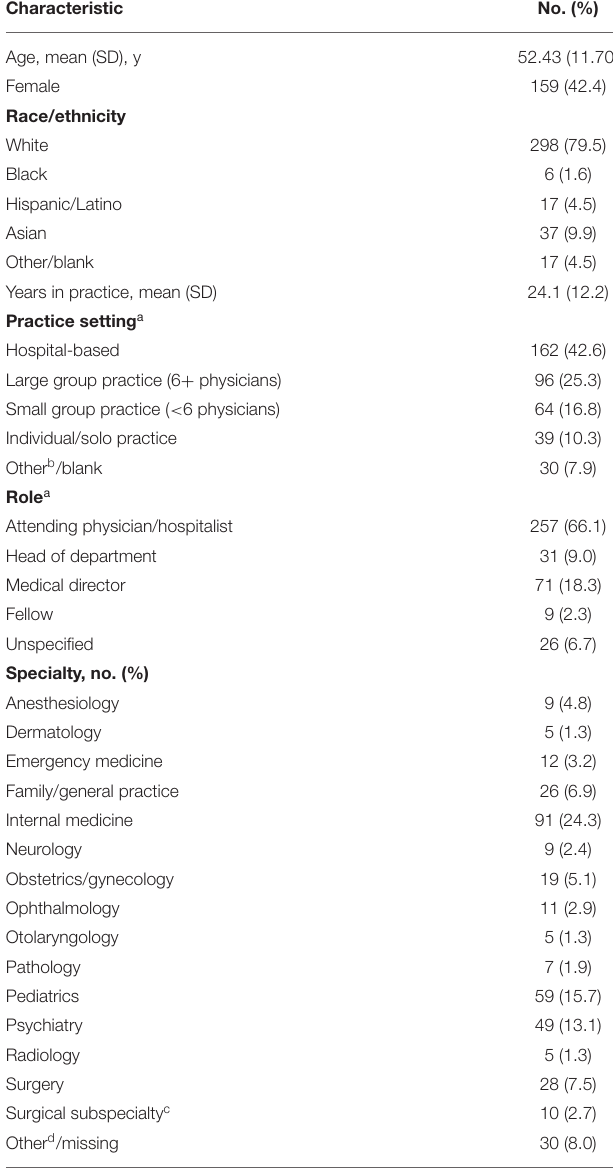
TABLE 1 | Demographic and professional characteristics of physician survey responders included in final analysis ( N = 375).